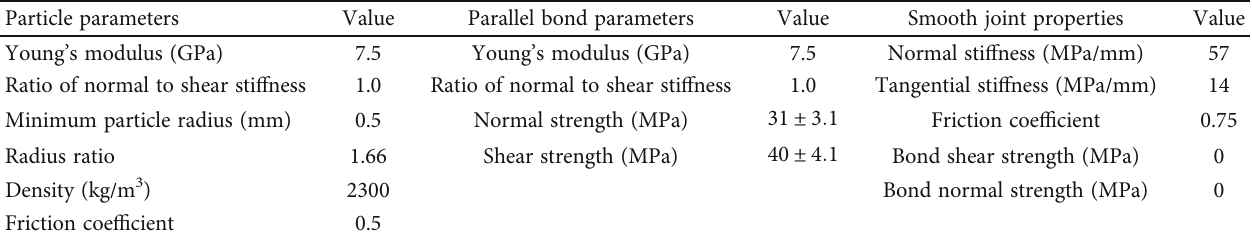
Figure 6: Construction process of anisotropic structure surface shear numerical model: (a) generation of particles; (b) change of contact model; (c) adding joints; (d) changing the joint contact model. Table 2: Numerical calculation of microscopic mechanical parameters of low-strength rock joint.